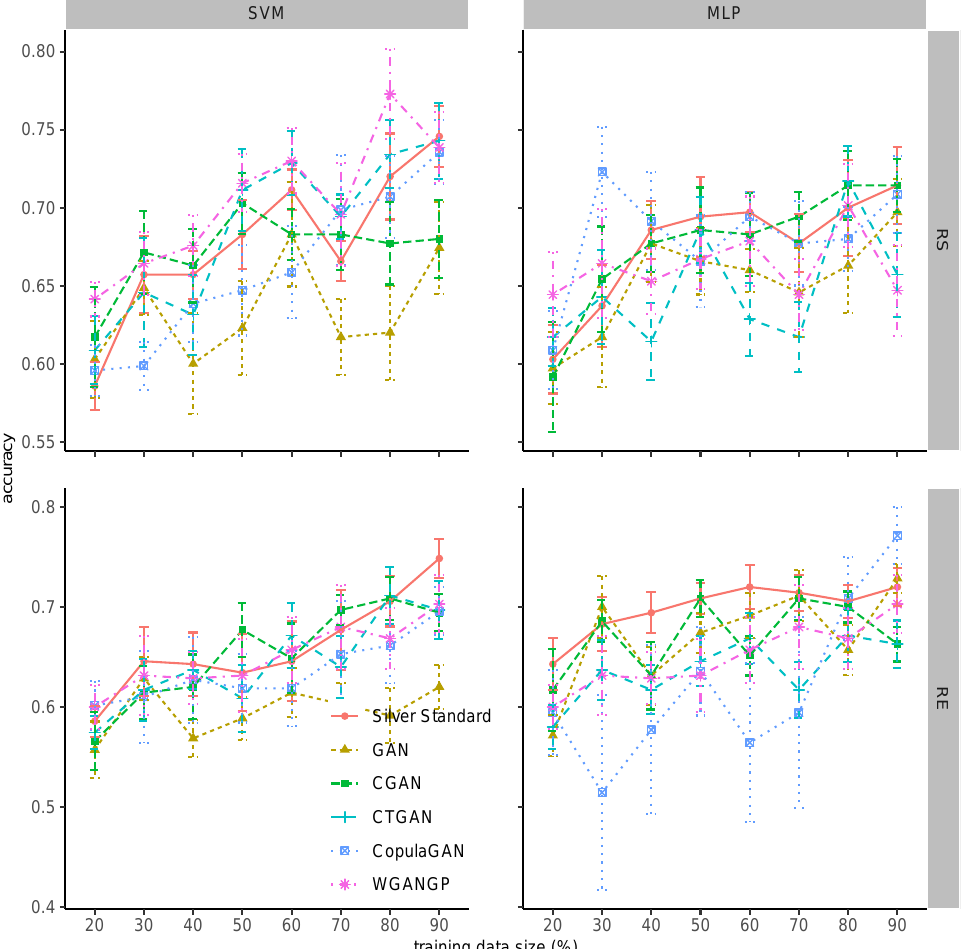
Figure 5. The mean accuracy of classifiers trained on data generated by GAN variants versus the size of the training data (as a percentage of the Train data) using the BCC dataset. Rows ( top and bottom ) show the RS and RE sampling, while columns ( left and right ) indicate the SVM and MLP classifiers. The Silver Standard only considers Train data (no generated data) for training the classifier. Error bars show the standard error of the mean over 10 samples for each